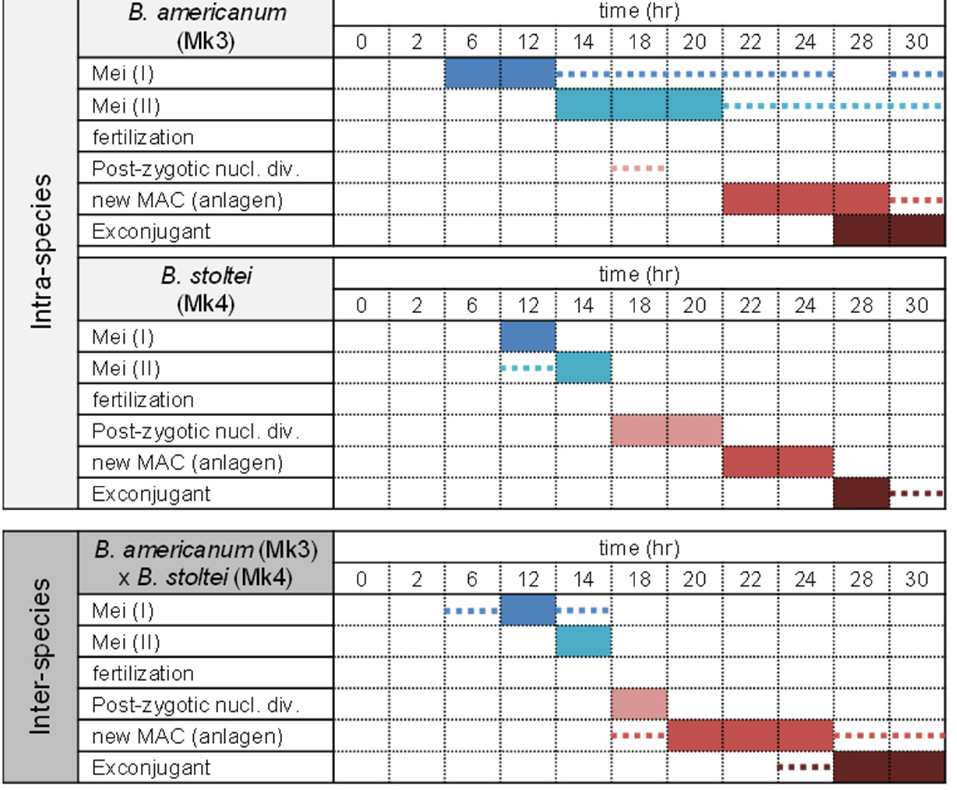
Figure 3. Time course of nuclear changes during conjugation in intra-species ( B. americanum – B. americanum and B. stoltei – B. stoltei ) pairs and in inter-species ( B. americanum – B. stoltei ) pairs. Colored boxes: nuclear stages most frequently observed at the indicated time. Dotted lines: stages observed slightly at the indicated time.